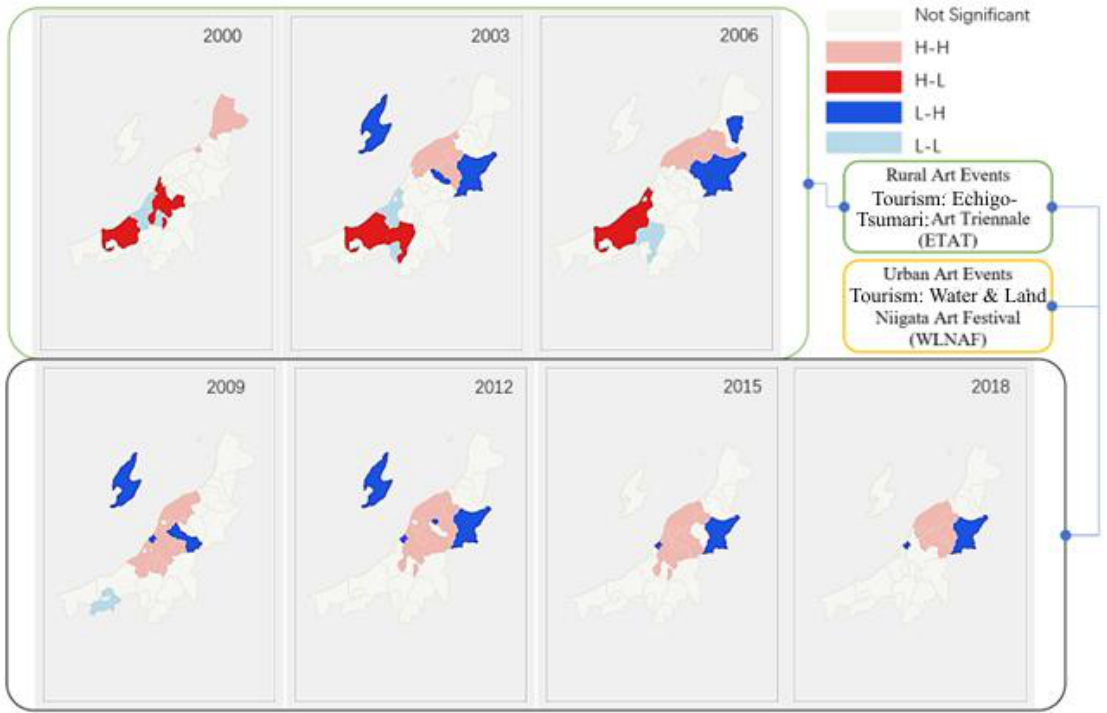
Figure 16. Local indicators of spatial association of household number growth rate